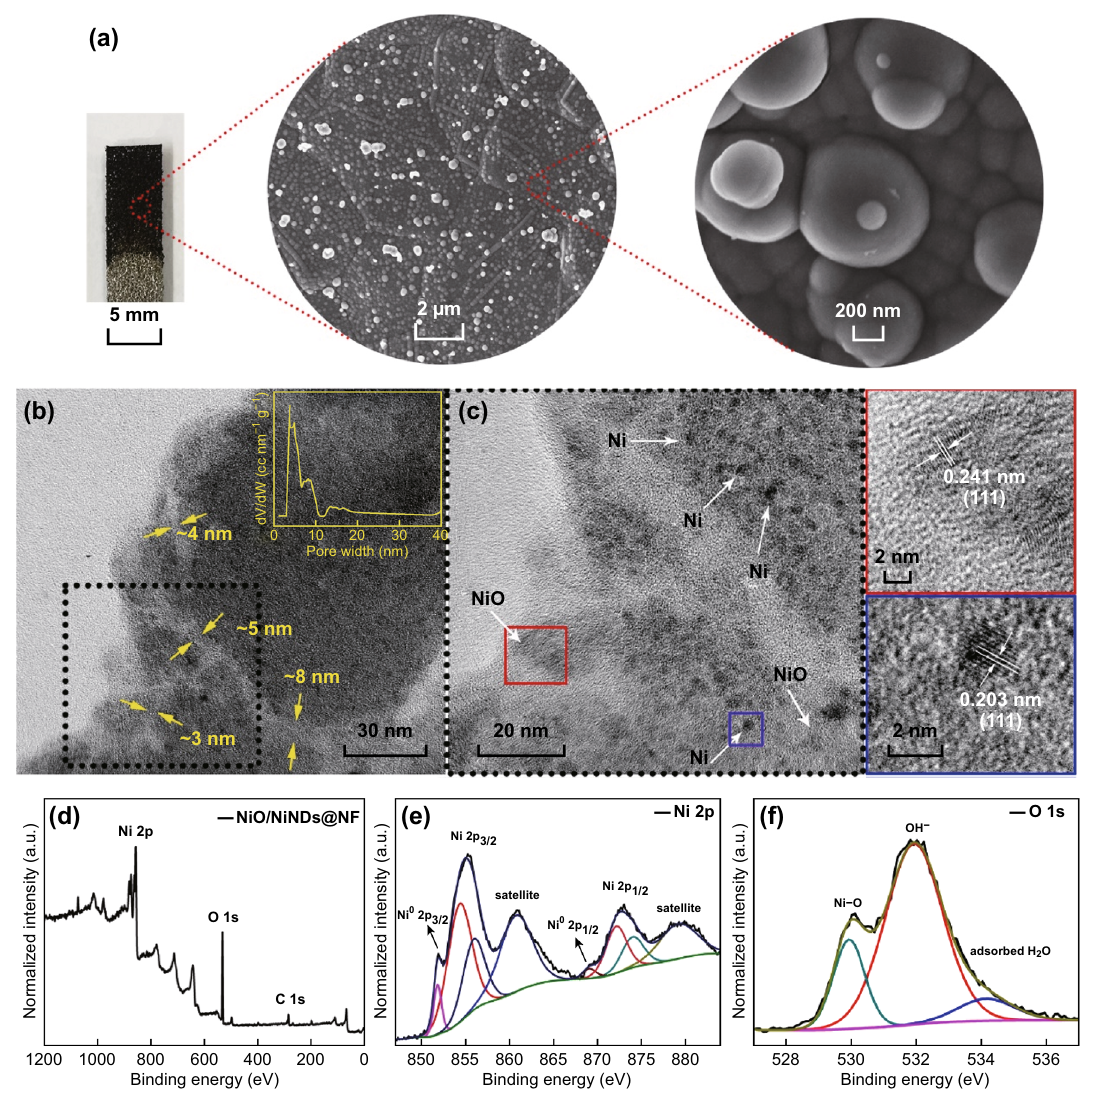
Fig. 1 Structure and components of NiO/NiND composites after 120 s of deposition. a Photographic images of the NiO/NiNDs@NF electrode, SEM image, and the corresponding magnified SEM image. b TEM and c HRTEM images (the magnified view of the NiO and Ni crystal lat‑ tice is in the red and blue frame respectively); inset of b is the corresponding BJH pore size distribution curve shown by the yellow line; d – f full XPS spectrum, and XPS spectra of Ni 2 p and O 1 s . (Color figure